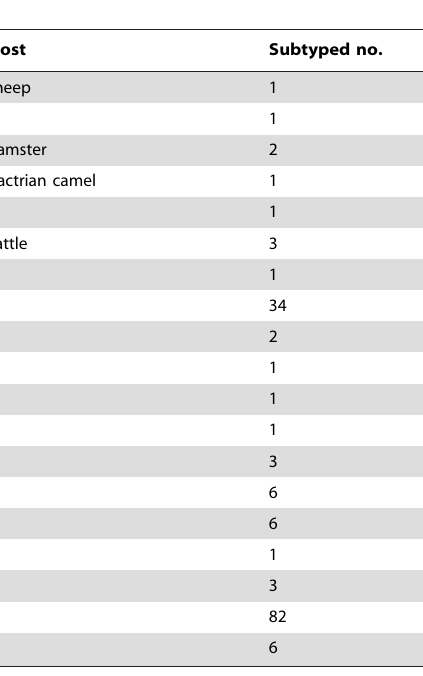
Table 3. MLST subtypes of C. andersoni from different hosts worldwide.